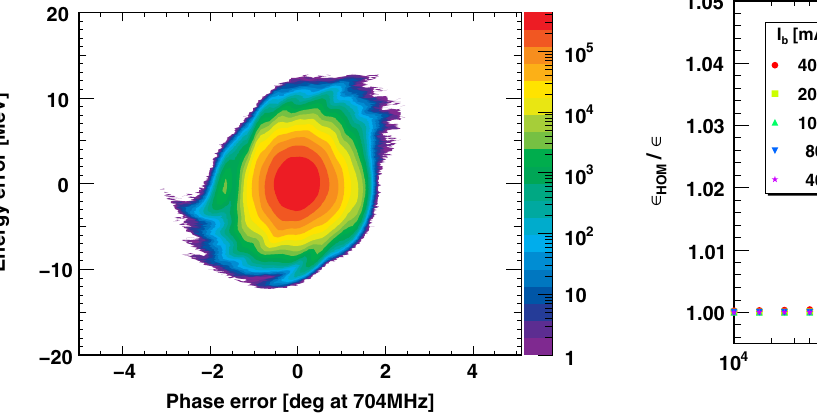
FIG. 7. 2D phase space histogram at the exit of 1000 linacs with rf errors, but no HOM present. The phase space area is increased significantly compared to Fig. 5. Settings: uniform distributed rf errors (0.5 (cid:8) in phase and 0.5% in magnitude), no HOM, N ¼ 1000 , see Table VI.